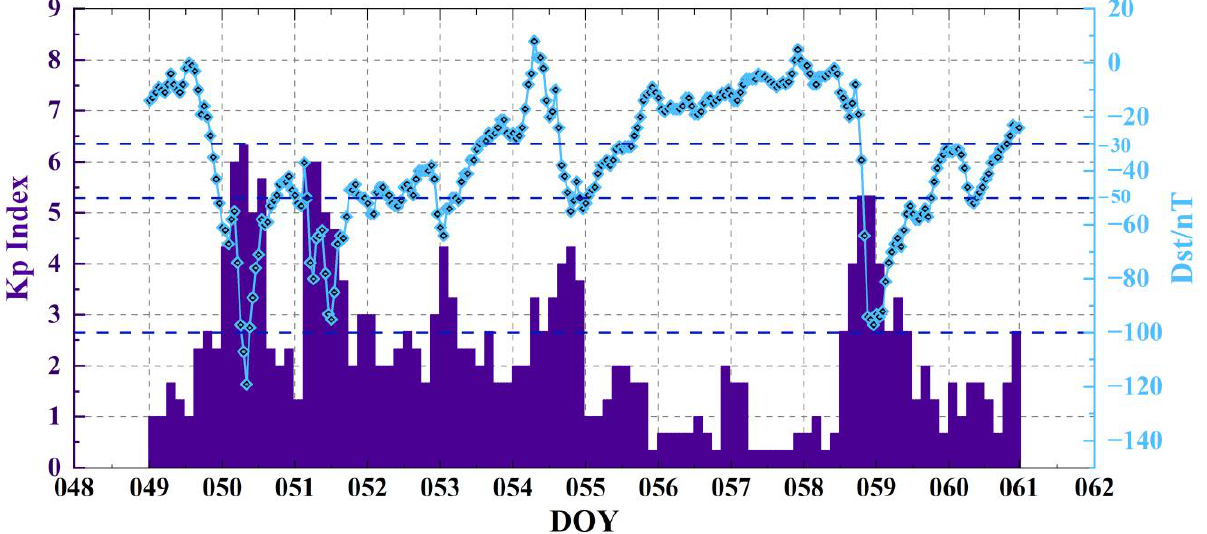
Figure 6. Geomagnetic activity during the geomagnetic storm period (DOY049~060). (Blue dashed lines ( − 30, − 50, and − 100 nT) represent the boundary between weak, moderate, and intense magnetic storms , respectively.)